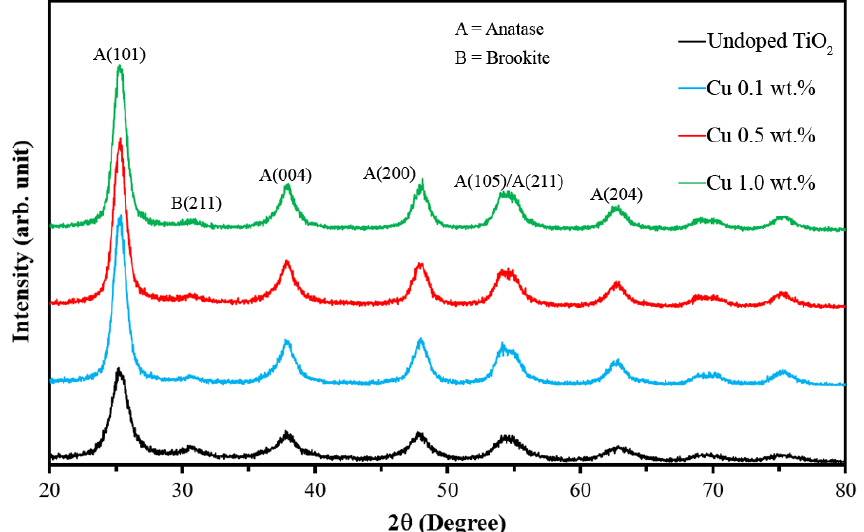
Figure 2. XRD patterns of Cu-doped TiO 2 nanoparticles, Anatase: ICCD card no. 00-064-0863, Brookite: ICCD card no. 01-071-4943.